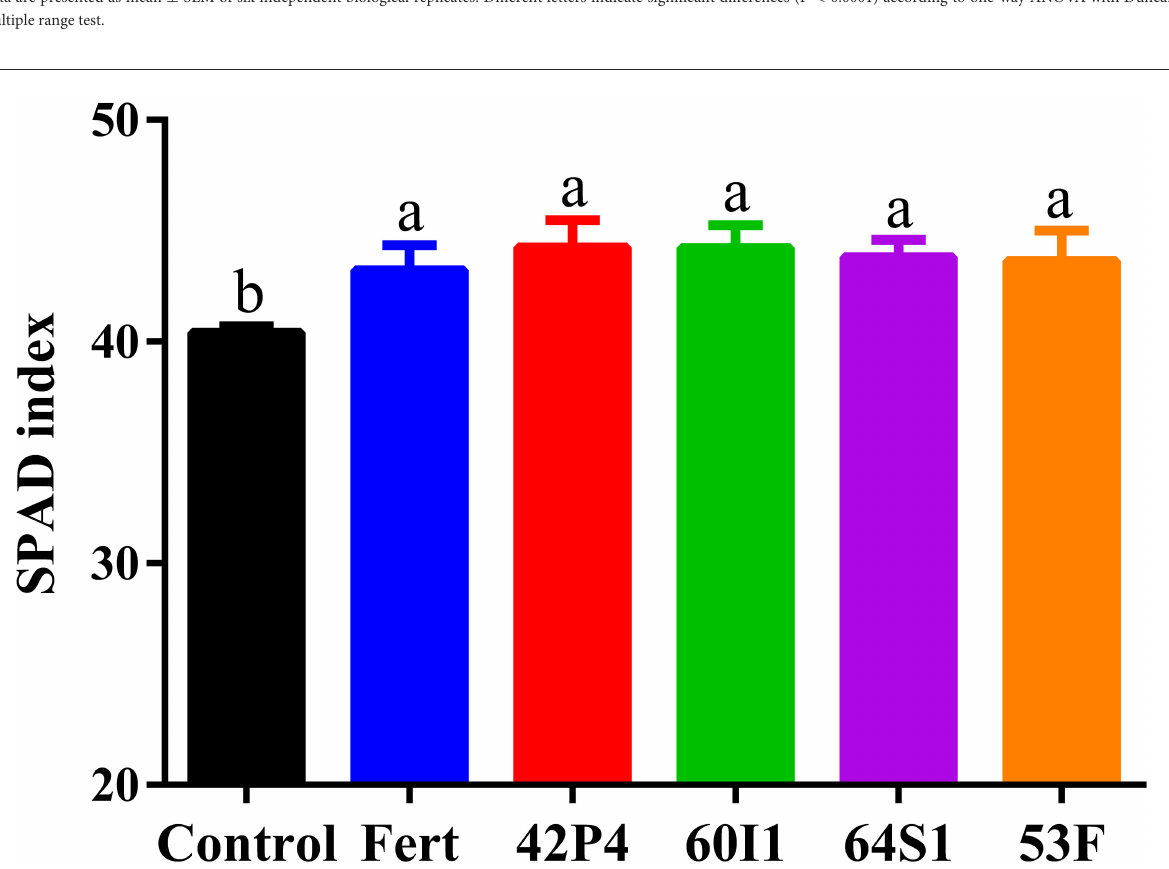
had the highest concentration of (-)-gallocatechin gallate (35.98mg g − 1 ), followed by Fertilized and Cellulosimicrobium 60I1 (30.95 and 15.61 mg g − 1 , respectively) and they differed from the Control (12.15 mg g − 1 ). The Fertilized had the highest concentration of naringin (68.68 mg g − 1 ), followed by